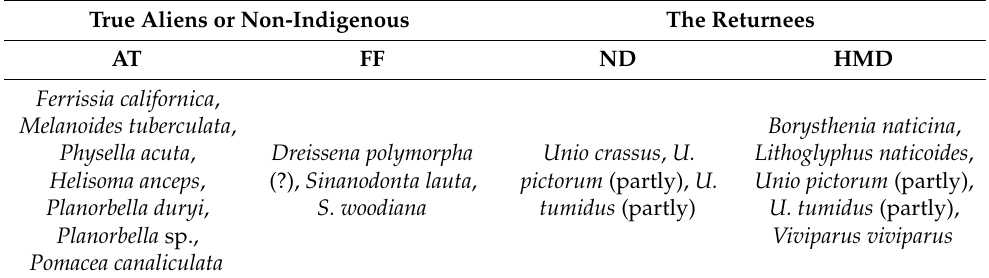
Figure 3. A classification scheme for the newly registered in the fauna of Siberia species of freshwater Mollusca. ND—natural dispersal. HMD—human-mediated dispersal. Table 2. Classification of species of neobiotic freshwater mollusks in Siberia according to their status in the region